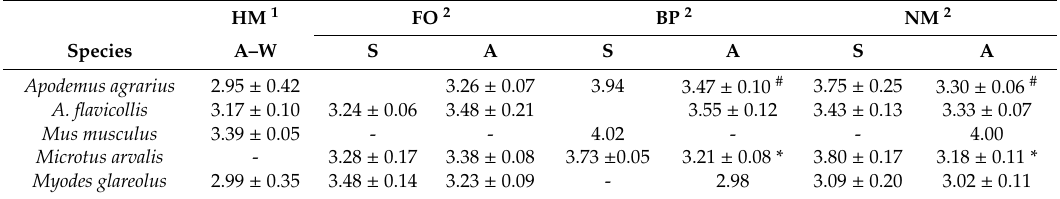
Table 5. Comparison of the body condition (C ± SE) of small mammals in fruit orchards, buildings and natural habitats of Lithuania. HM 1 FO 2 BP 2 NM 2 Species A–W S A S A S A Apodemus agrarius 2.95 ± 0.42 3.26 ± 0.07 3.94 A.